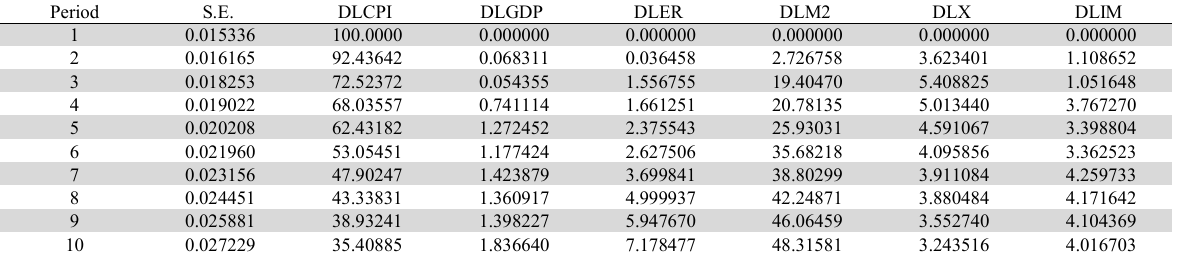
Variance decomposition of